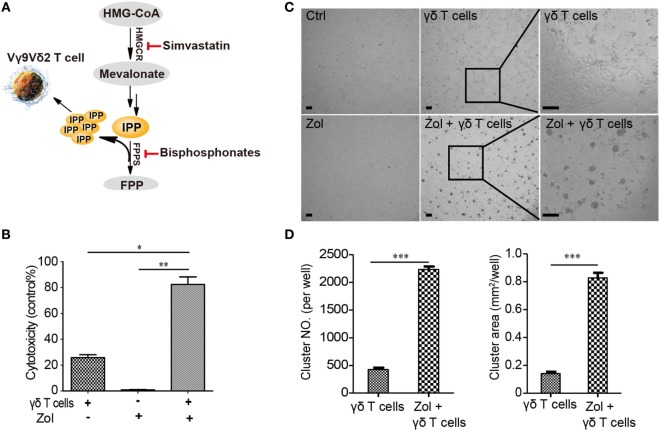
Zoledronate enhances the killing of activated hepatic stellate cells (aHSCs) by Vγ9Vδ2 T cells. (A) Schematic illustration of the mevalonate pathway and the function of simvastatin and bisphosphonates (HMGCR, 3-hydroxy-3-methylglutaryl-CoA reductase; FPPS, farnesyl pyrophosphate synthase; IPP, isopentenyl pyrophosphate). (B) LX-2 cells (T) pretreated with 5 µM zoledronate (bisphosphonate) were more sensitive than untreated controls to killing by Vγ9Vδ2 T cells (E) at an E:T ratio of 10; recording of lactate dehydrogenase (LDH) activity. Data are presented as mean ± SEM of three replicates from a representative experiment of three independent experiments. (C) Representative transmitted-light images showing LX-2 cells pretreated with zoledronate (5 µM) resulted in more killing and more clustered Vγ9Vδ2 T cells. Scale bar, 100 µm. (D) The number (NO.) and size (area) of Vγ9Vδ2 T cells clusters in (C). Data are presented as mean ± SEM of four replicates from a representative experiment of two independent experiments. *P < 0.05; **P < 0.01, ***P < 0.001.